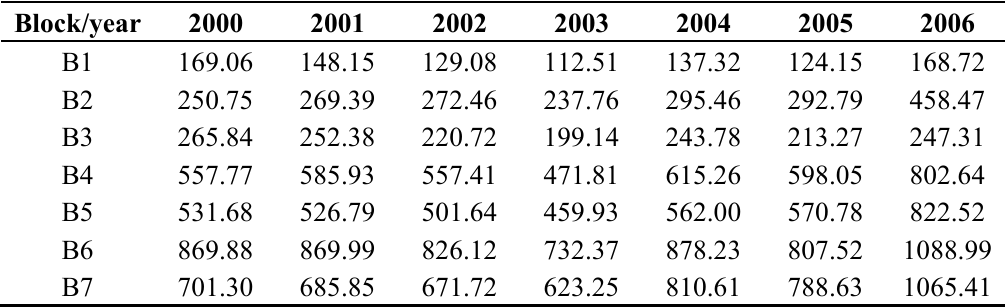
Table 3. Indirect Water Productivity (IWP) in the Castile and León Region, 2000–2006 (€/m 3 , constant prices), urban